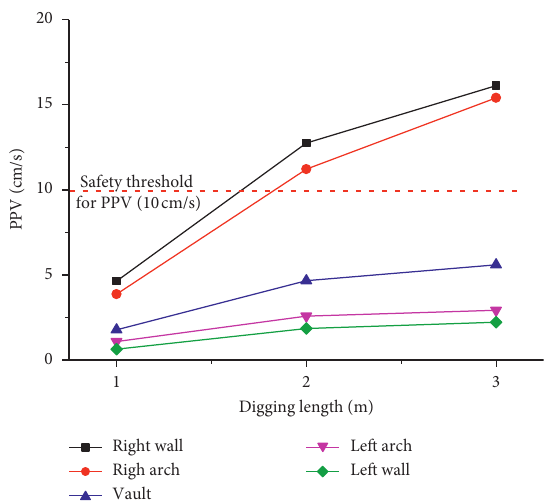
Figure 16: Changes of maximum PPV with digging length.